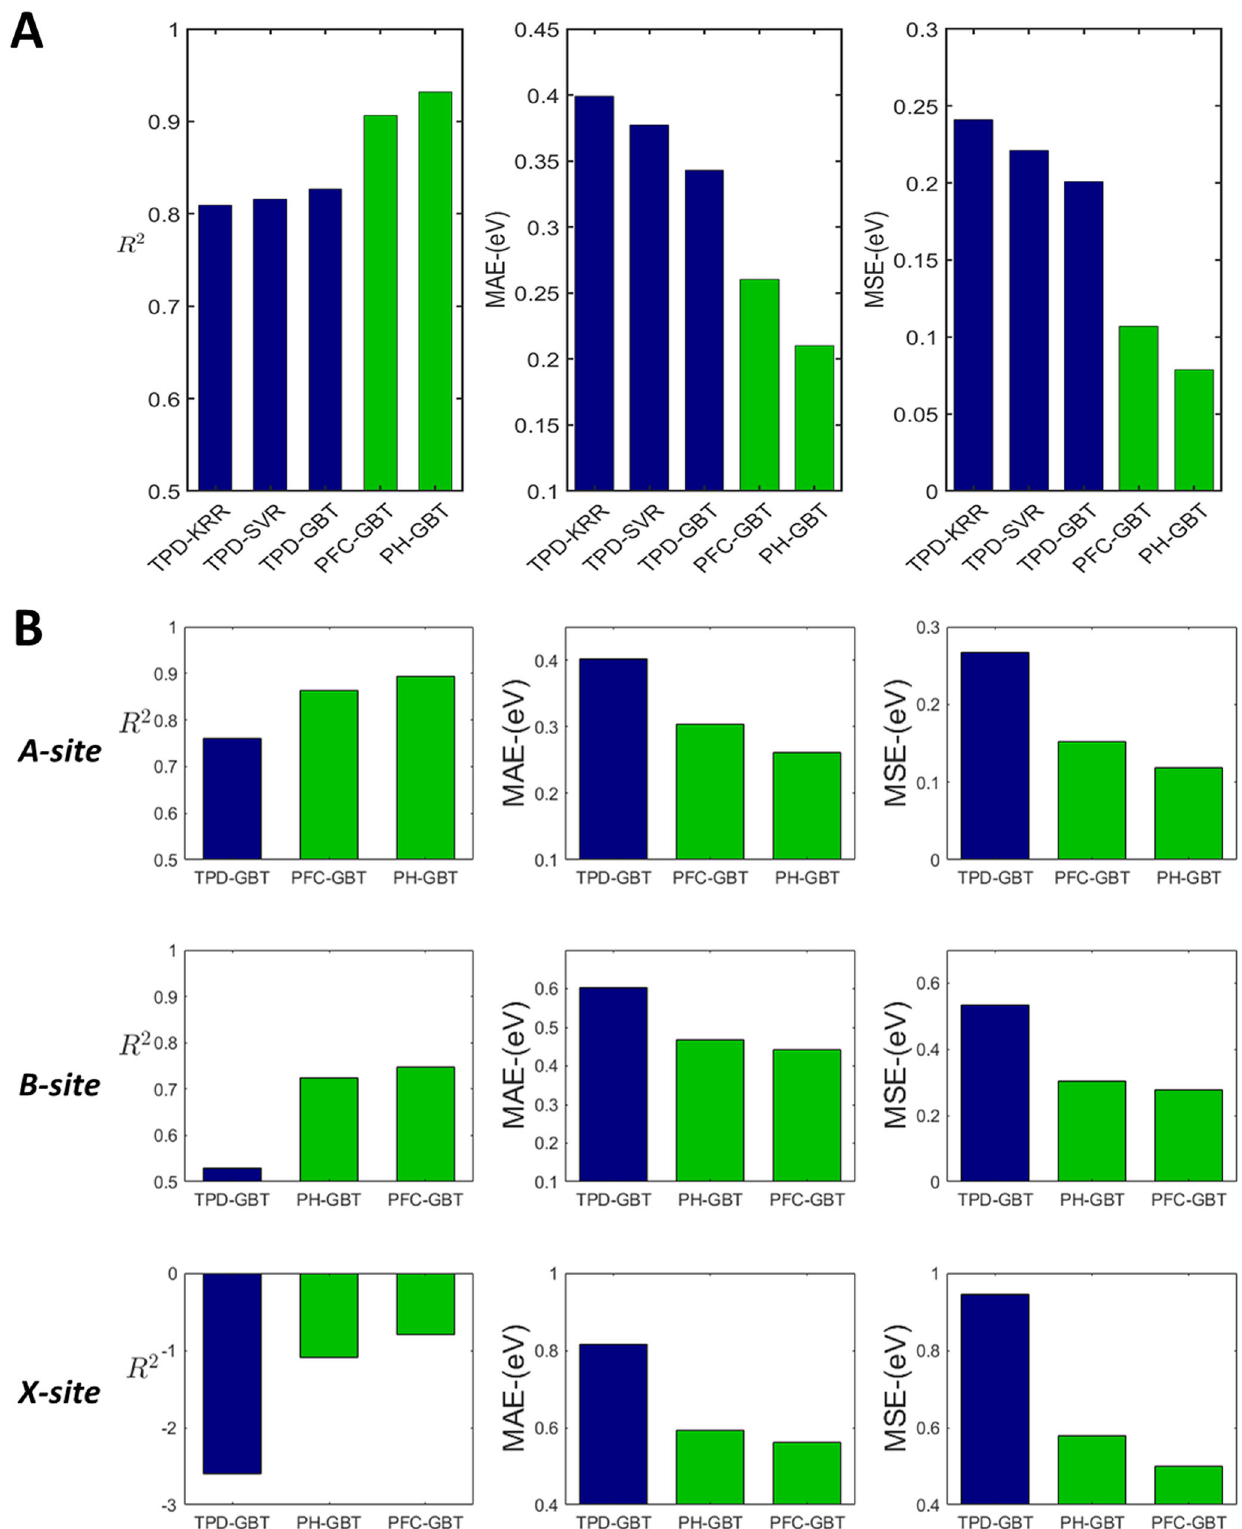
Fig. 5 A systematic comparison between PF-GBT models and TPD-based machine learning models. A Results for the 10-fold cross- validation for OIHP bandgaps from 1346 OIHP database 16 . Three TPD-based machine learning models (blue bars), including TPD-based kernel ridge regression (TPD-KRR), TPD-based support vector regression (TPD-SVR) and TPD-based gradient boosting tree (TPD-GBT) are used in comparison with persistent function-based models (green bars), including PFC-GBT and PH-GBT. B Results for Leave One Group Out (LOGO) cross-validation test for A-site, B-site and